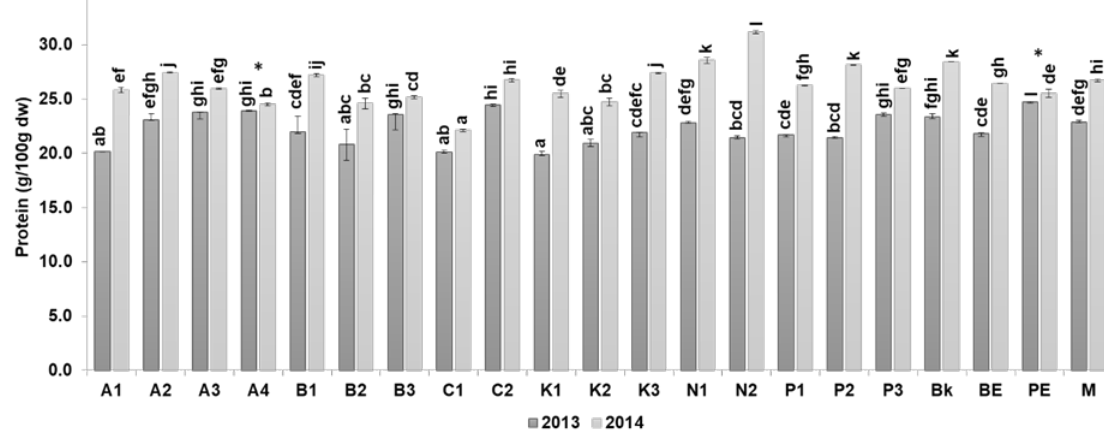
Figure 2. Protein content of 10 common bean cultivars from 2013 and 2014, grouped according to their morphological characteristics. Cultivars: Arikara yellow (A1, A2, A3, A4), butter bean (B1, B2, B3), cranberry (C1, C2), red kidney (K1, K2, K3), navy (N1, N2), pinto (P1, P2, P3), black (Bk), brown eyed (BE), pink eyed (PE), and tarrestre (M). The absence of common letters (a–l) indicates significant differences at p < 0.05; Tukey’s multiple range tests were performed for each year separately. *indicates that it does not differ significantly at p < 0.05 between the two harvesting years.